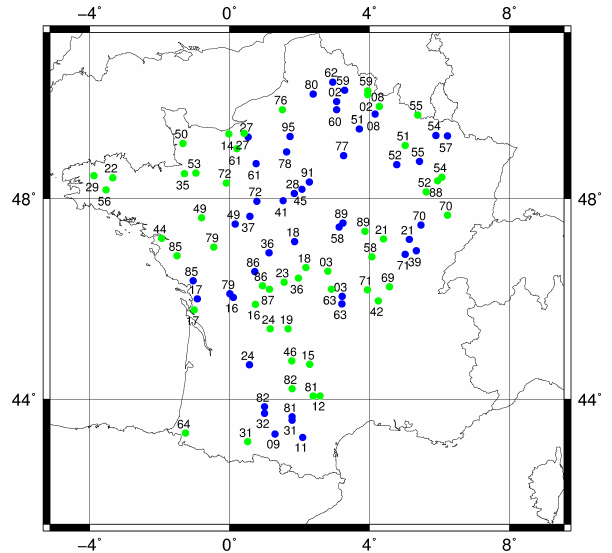
Figure 1. Location of the 45 cropland and 48 grassland 8km × 8km grid cells (blue and green dots, respectively) and the corresponding département